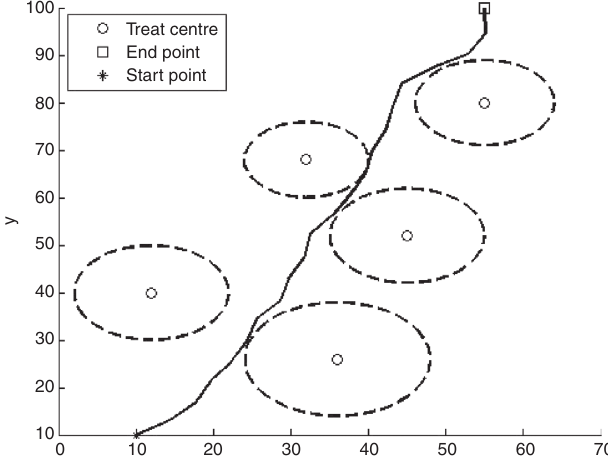
Figure 4. UCAV Flying